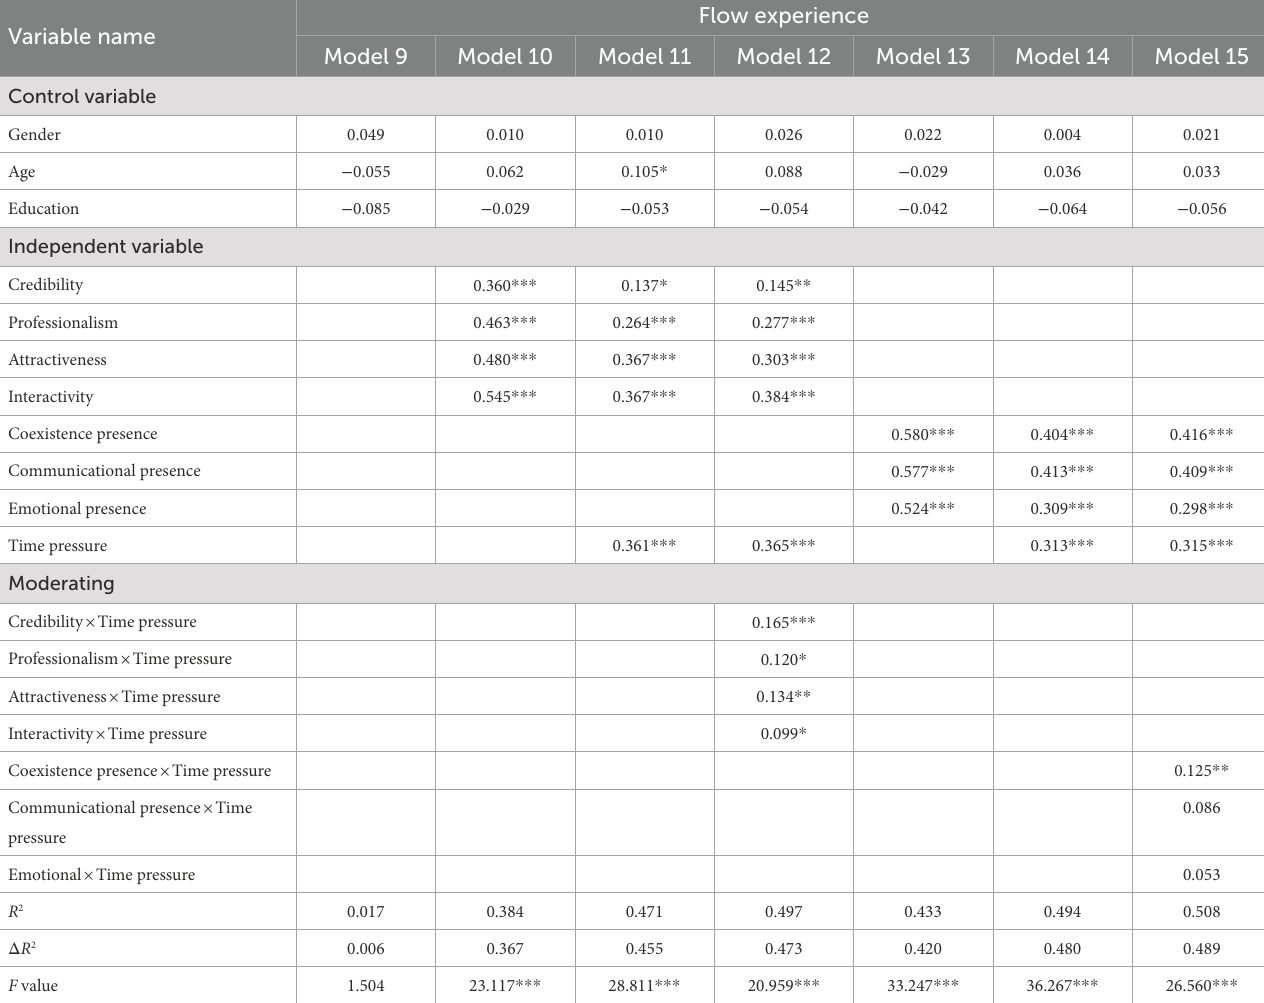
TABLE 6 Results of the hierarchical moderated regression analysis ( n = 268).